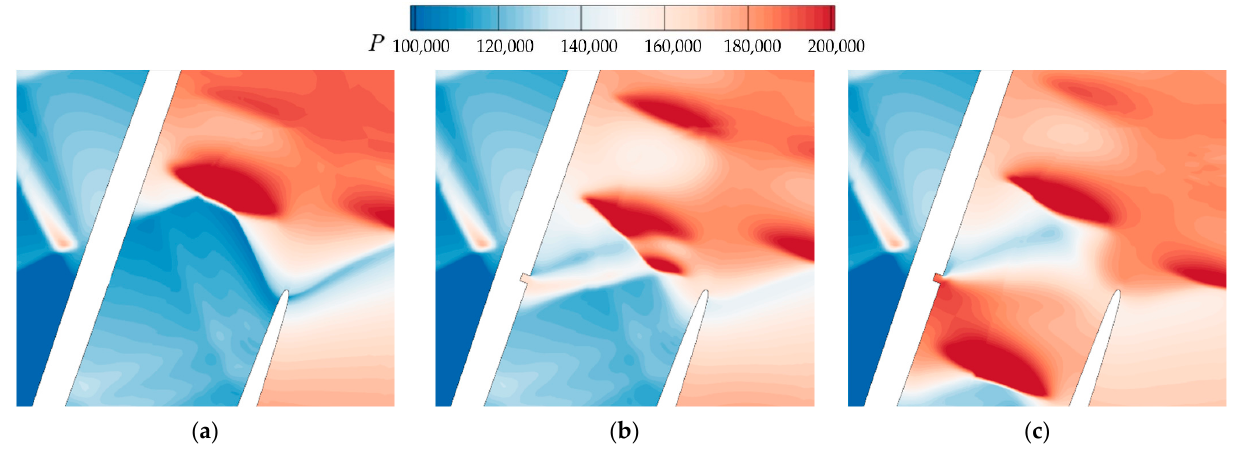
Figure 11. Static pressure contours with different strengths of jet: ( a ) baseline; ( b ) 𝑝 (cid:3037)∗ = 165 kPa ; ( c ) 𝑝 (cid:3037)∗ = 210 kPa .